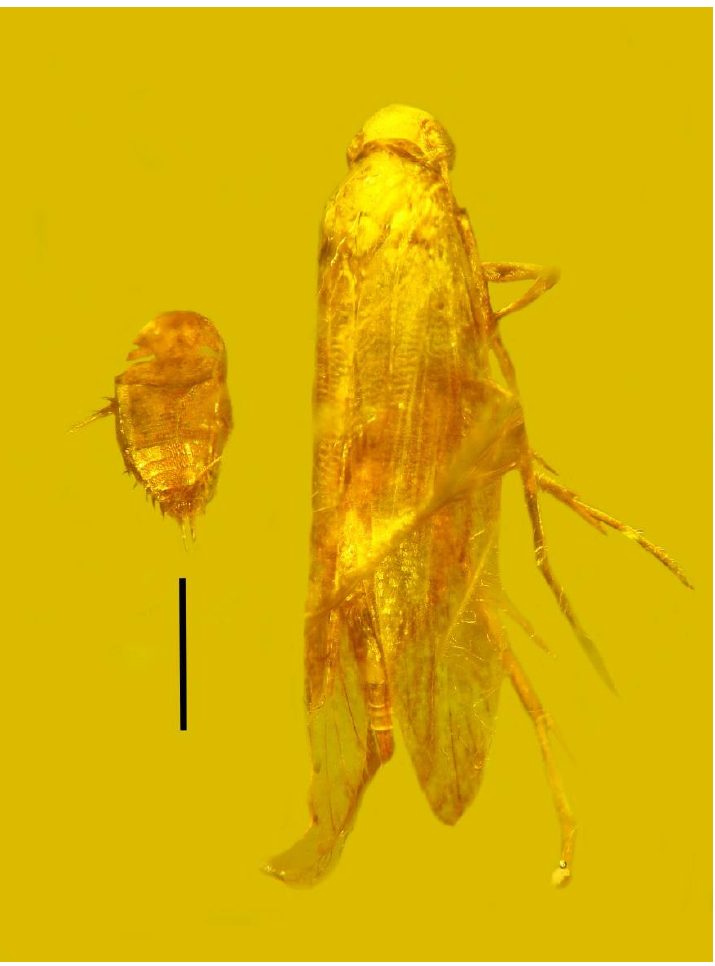
Figure 14. A member of the Trichopseniinae (Coleoptera: Staphylinidae) adjacent to a tineid moth (Lepidoptera: Tineidae) in Dominican amber. Scale bar = 750 µm.